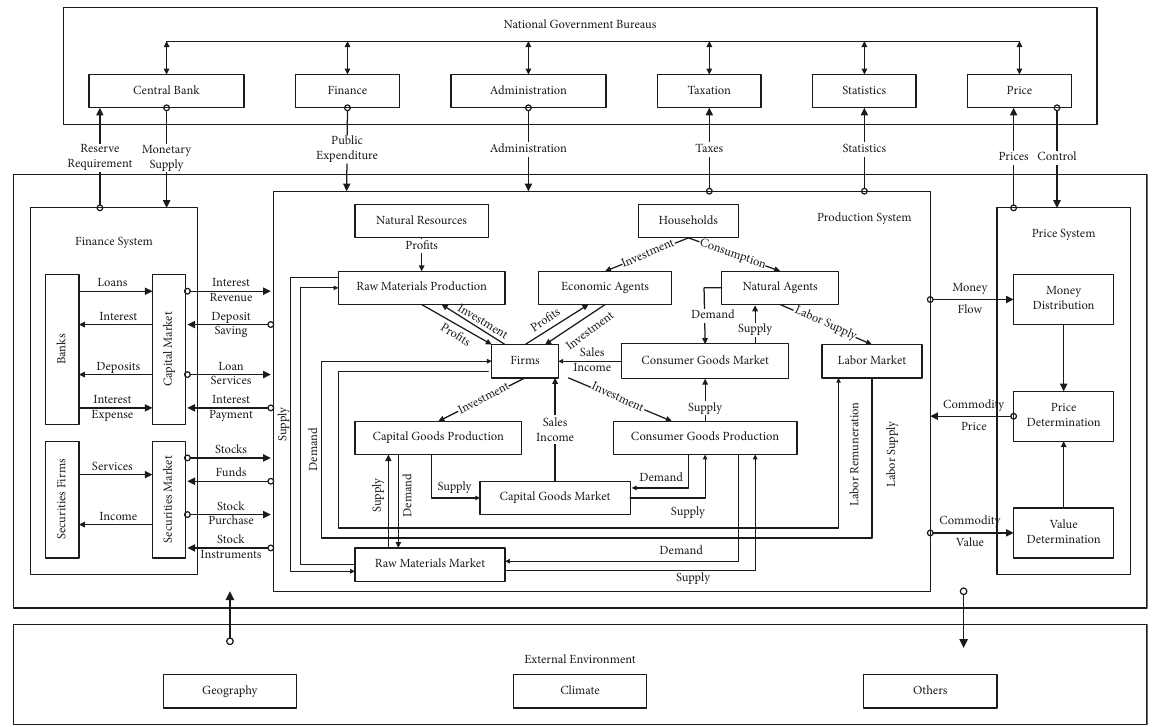
Figure 1: National economic simulation system (source: On Wealth I